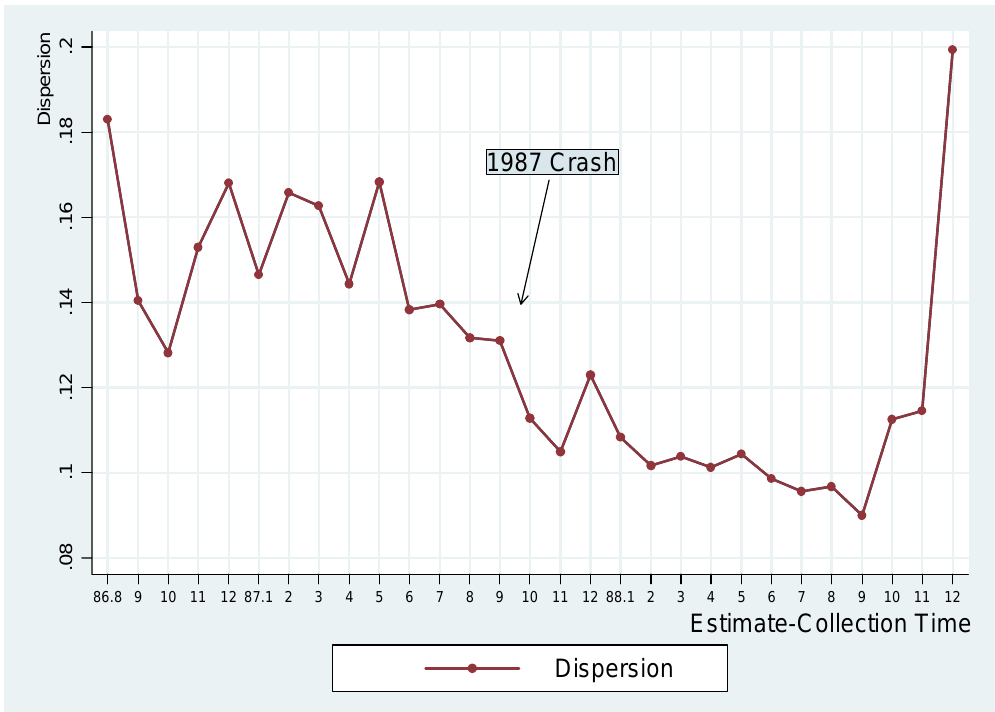
Figure 5: Monthly Average AFD (1986.8 -